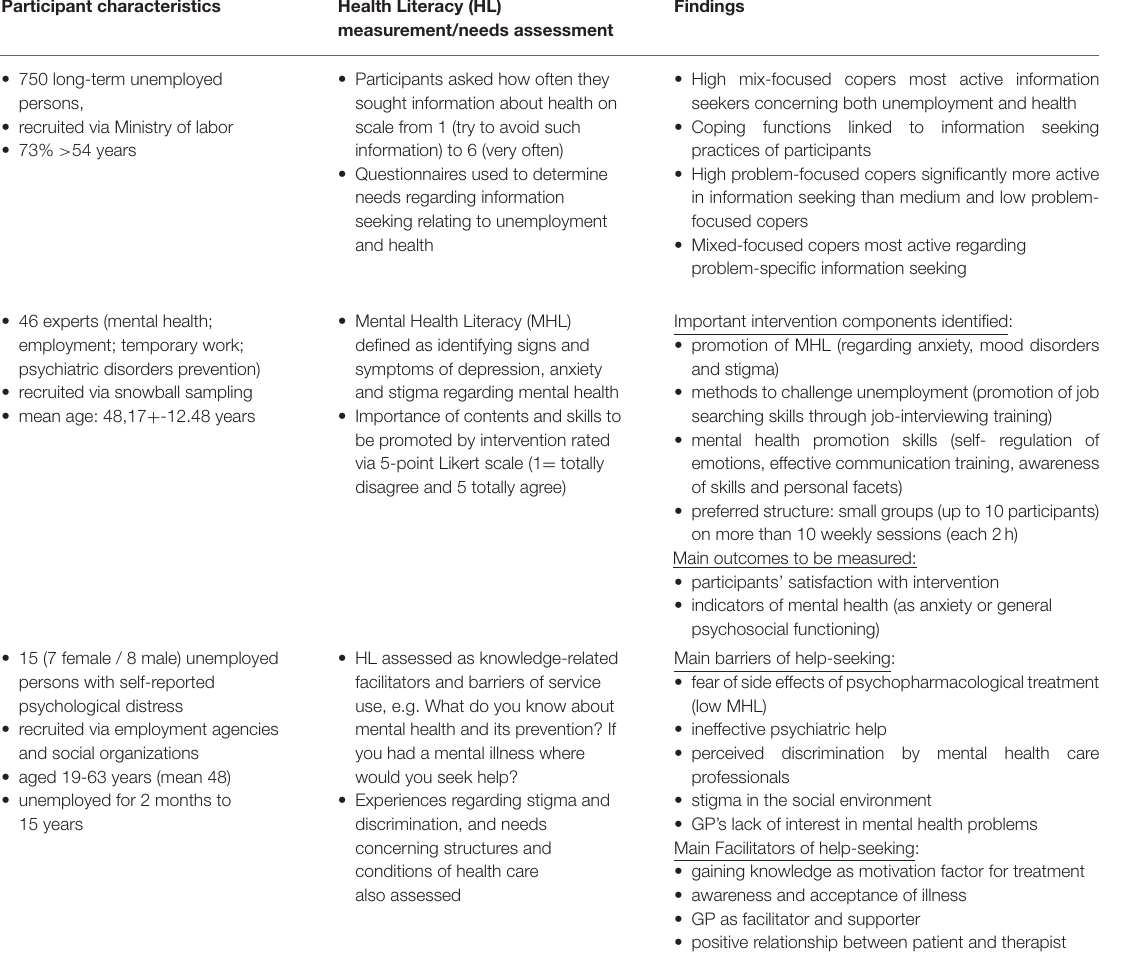
TABLE 1 | Characteristics and summary of findings of the five peer-reviewed and one gray literature source (31) included in the scoping review. References,